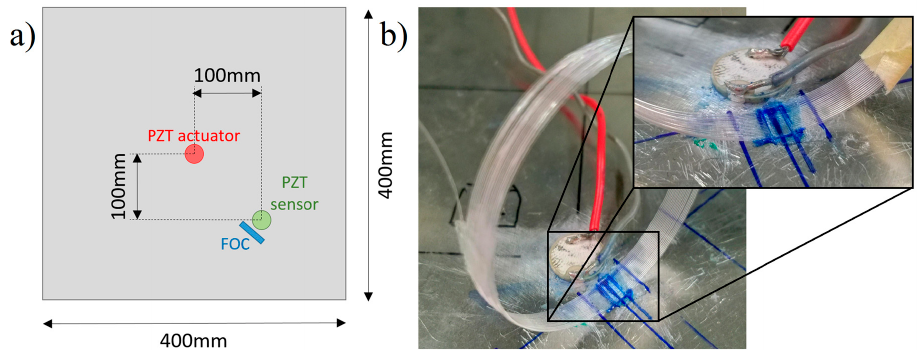
Table 1. Group and phase velocity of A0 fundamental wave propagation mode and associated wavelength of the propagating wave packets, as a function of the excitation frequency f . Figure 4. ( a ) Schematic of the actuator and sensor layout for active monitoring tests; ( b ) detail of the sensing optical fiber arranged in 20 loops and glued to the aluminium plate for active monitoring tests.